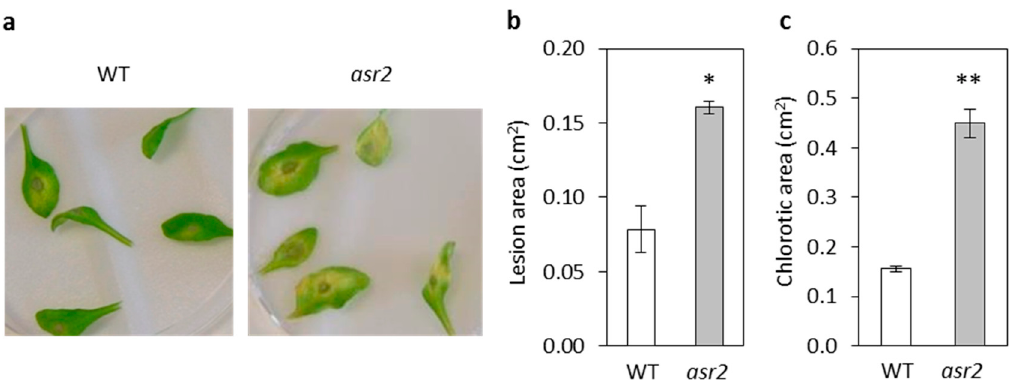
Figure 4. asr2 had increased susceptibility to the necrotrophic fungal pathogen Alternaria brassicicola . ( a – c ) A . brassicicola induced lesions at 3 dpi with ( a ) representative images of leaves, ( b ) size of Alternaria induced lesions, and ( c ) size of chlorotic regions. Values are averages ± SE of three biological replicates consisting of lesions measured from five inoculated leaves per plant. Asterisks indicate values that are significantly different (** p < 0.01, * p < 0.05 Student’s t -test) from wild-type (WT). Similar results were obtained in independent experiments.